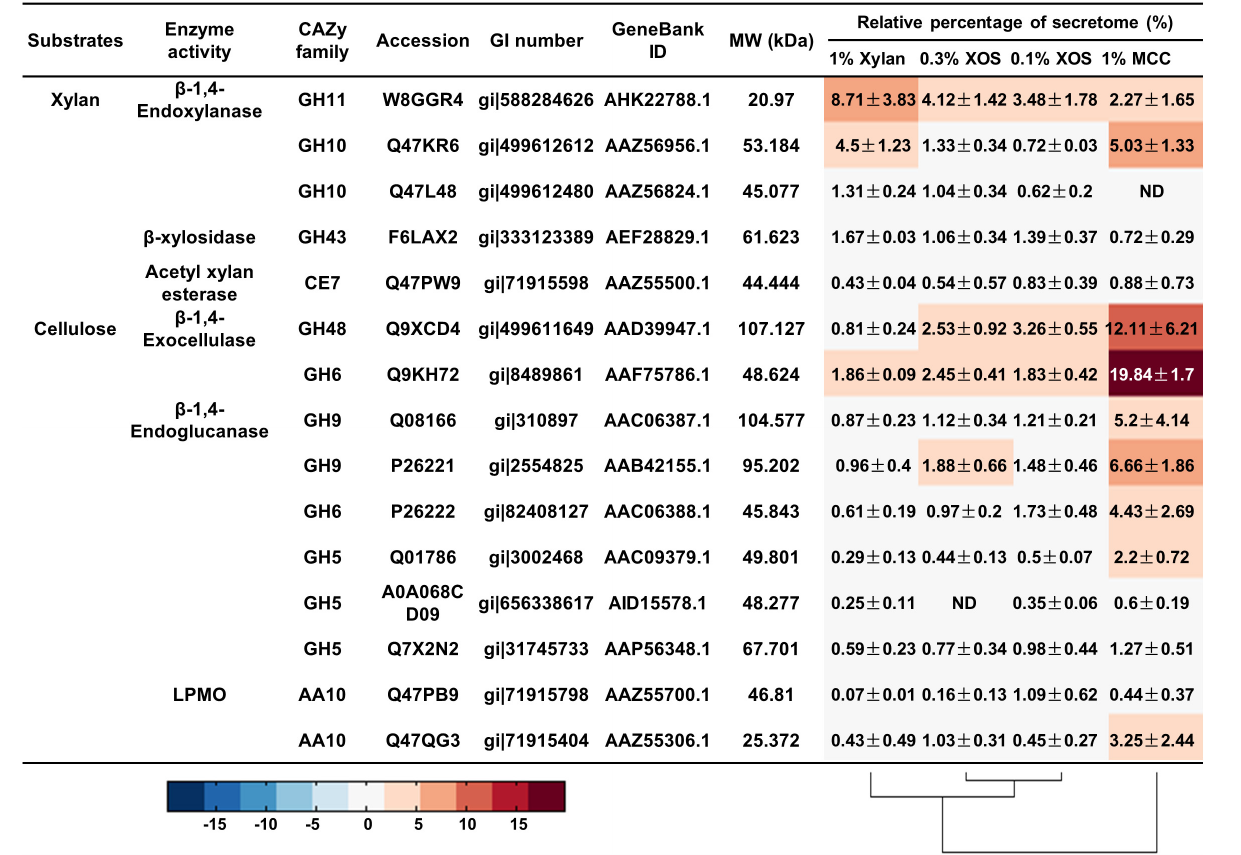
was detected with 3.25 ± 2.44% relative content when T.